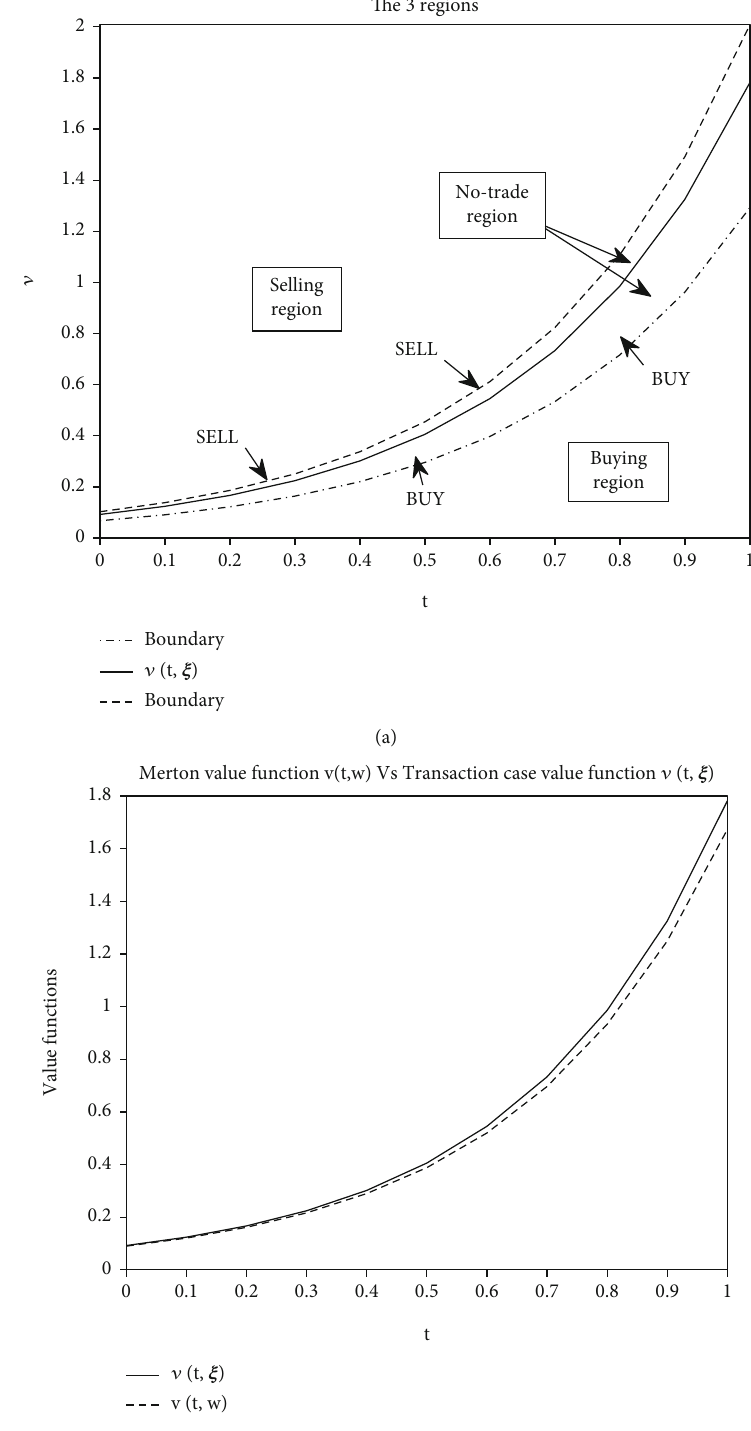
Figure 1: Plots of modi fi ed Merton value function and the value function in the three regions with λ = 0 : 5 . μ σ = 0 : 5, r = 0 : 09, ρ = 3, p = 0 : 5 , and β = 0 : 2 . Then, the portfolio becomes θ = 0 : 8286 2 1